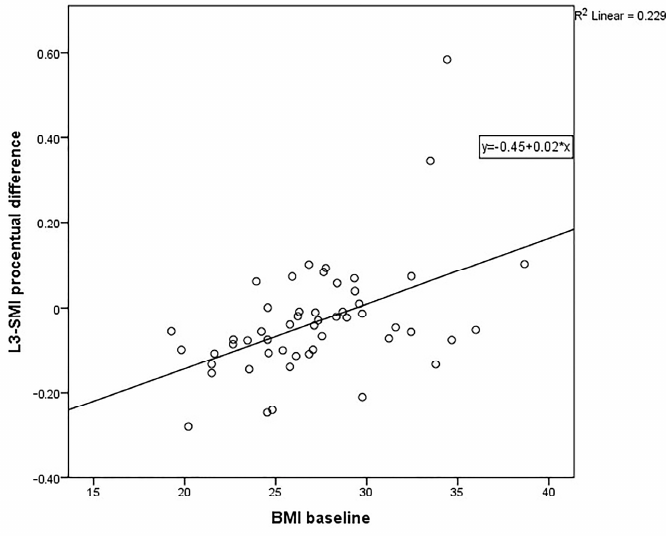
Figure 3. Linear regression for L3-SMI percentage change and BMI values at baseline.